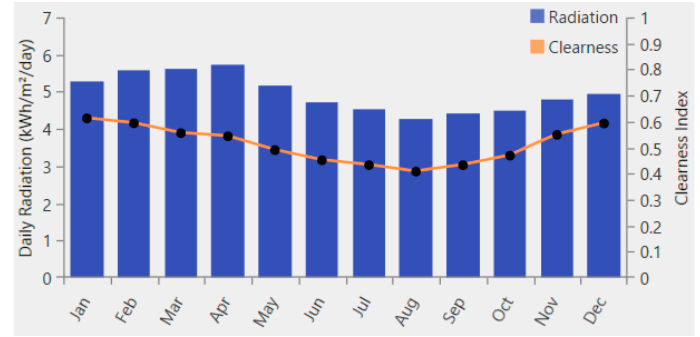
Figure 6. Daily solar radiation and clearness index on average.